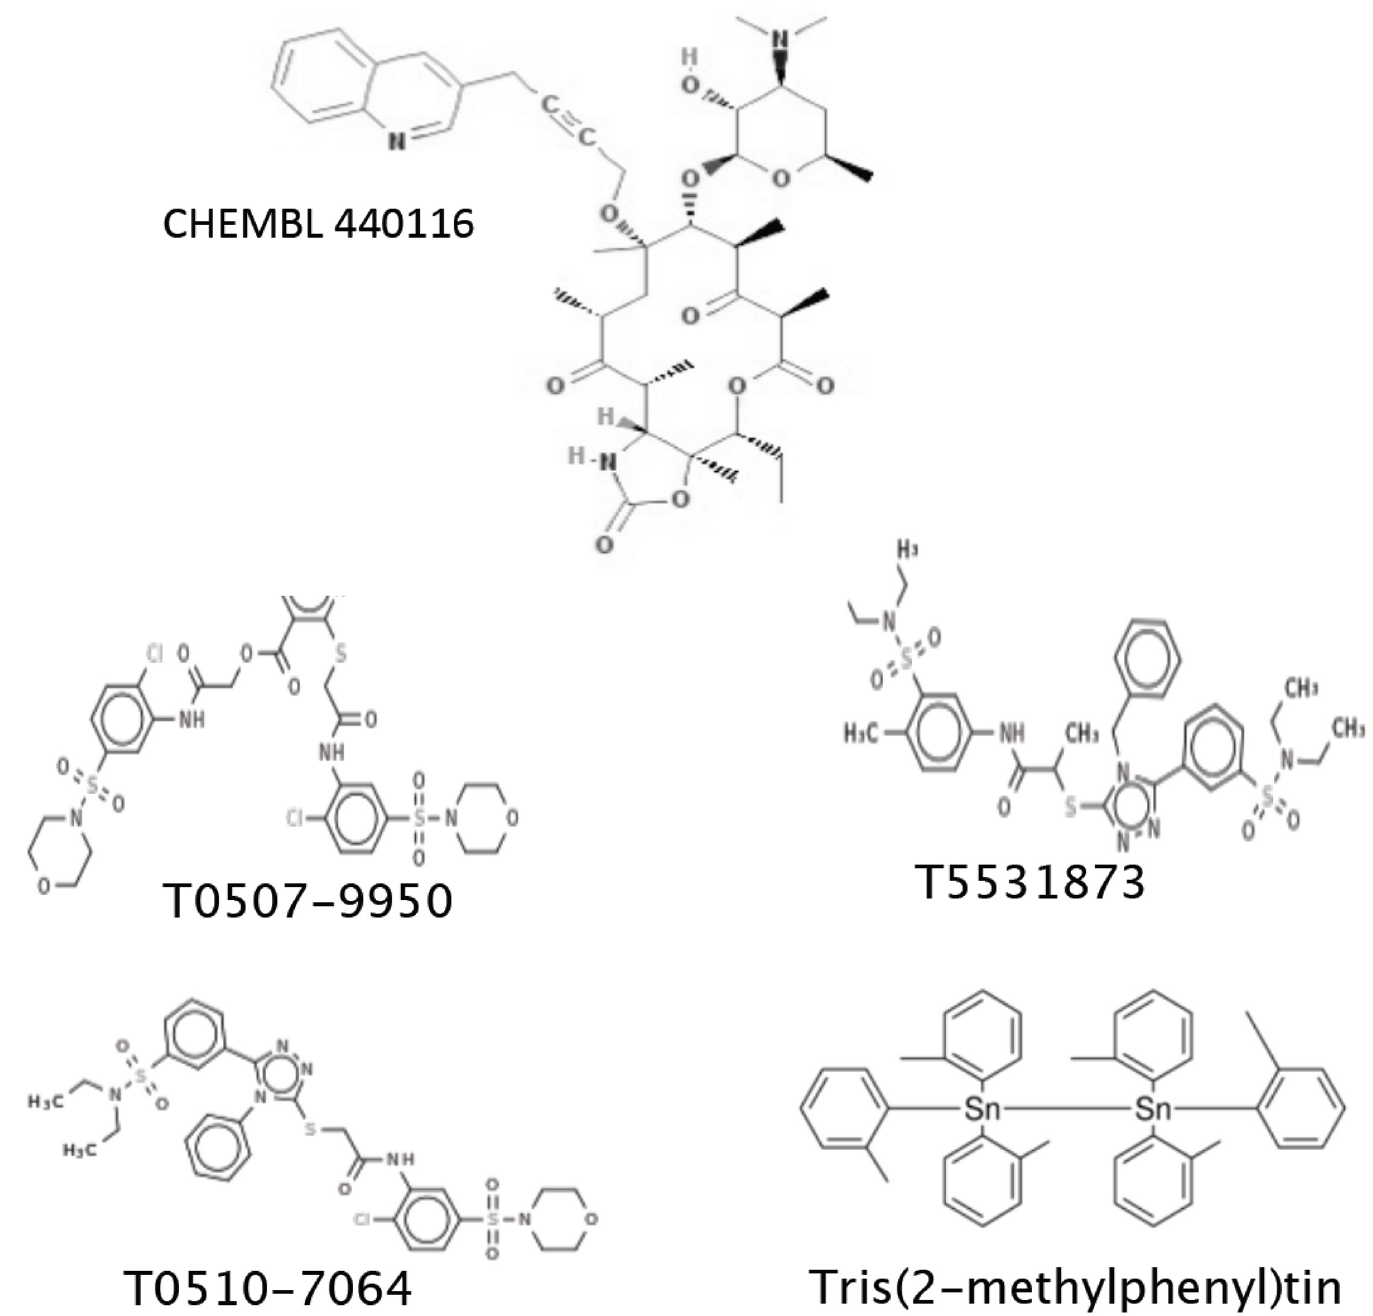
Fig 2. Compound Structures from Quantum modeling. Chemical structures of CHEMBL440116 and four other identified molecules which were acquired and